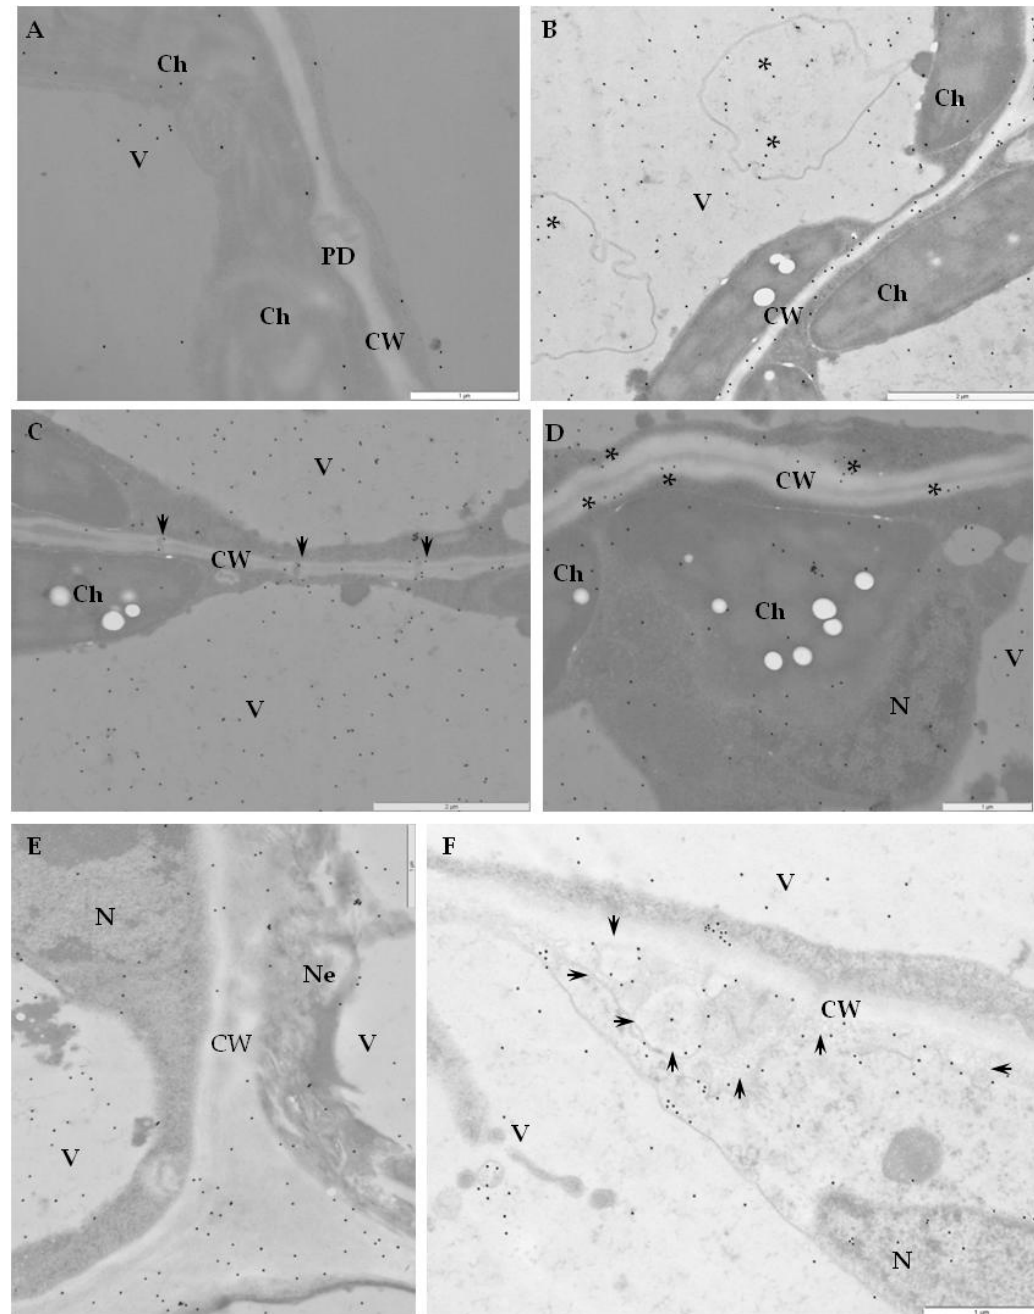
Figure 4. Immunogold labeling of RbohD protein in an incompatible interaction of potato S á rpo Mira plants with PVY NTN . ( A ) Gold particles indicating the presence of RbohD in chloroplast and vacuole in parenchyma cell of mock-inoculated potato S á rpo Mira plant. Bar 1 µ m. ( B ) Gold particles indicating the presence of RbohD in the cell wall, vacuoles, and membranous structures (*) 1 day after PVY NTN -inoculation. Bar 2 µ m. ( C ) RbohD gold deposition in plasmodesmata in the cell wall (arrows) and in the vacuole 1 day after PVY NTN inoculation. Bar 2 µ m. ( D ) RbohD localization along cell wall and in vacuole 7 days after inoculation at the early step of necrosis. Localization in chloroplast and cytoplasm. Bar 1 µ m. ( E ) RbohD deposition in necrotic epidermis cells 7 days after virus inoculation. Notice RbohD deposition in the cell wall, vacuole, and nucleus. Bar 1 µ m. ( F ) Deposition RbohD in paramular bodies along cell wall (arrows), vacuole and nucleus 7 days after virus inoculation. Bar 1 µ m. Ch—chloroplast, CW—cell wall, N—nucleus, Pd—plasmodesmata, V—vacuole, Ne—necrosis.